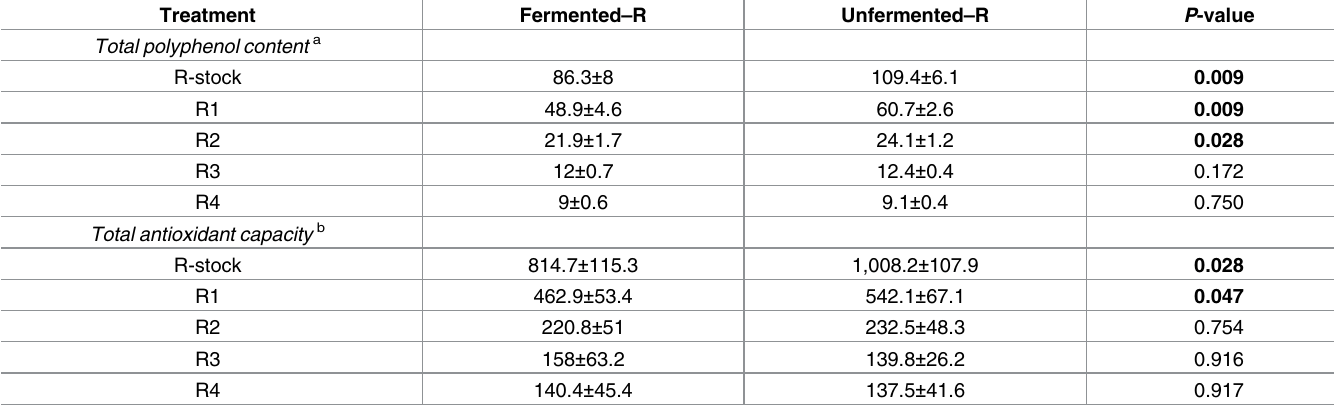
Table 1. Total polyphenol content and total antioxidant capacity in the rooibos aqueous